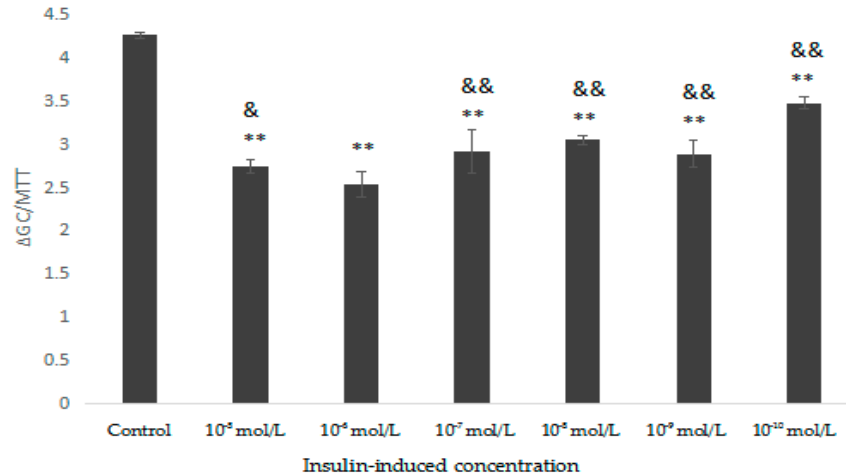
Figure 8. Effect of different concentrations of insulin on HepG2 cells insulin resistance. Compared with control, ** p < 0.01; compared with 10 − 6 mol/L, & p < 0.05, && p < 0.01.